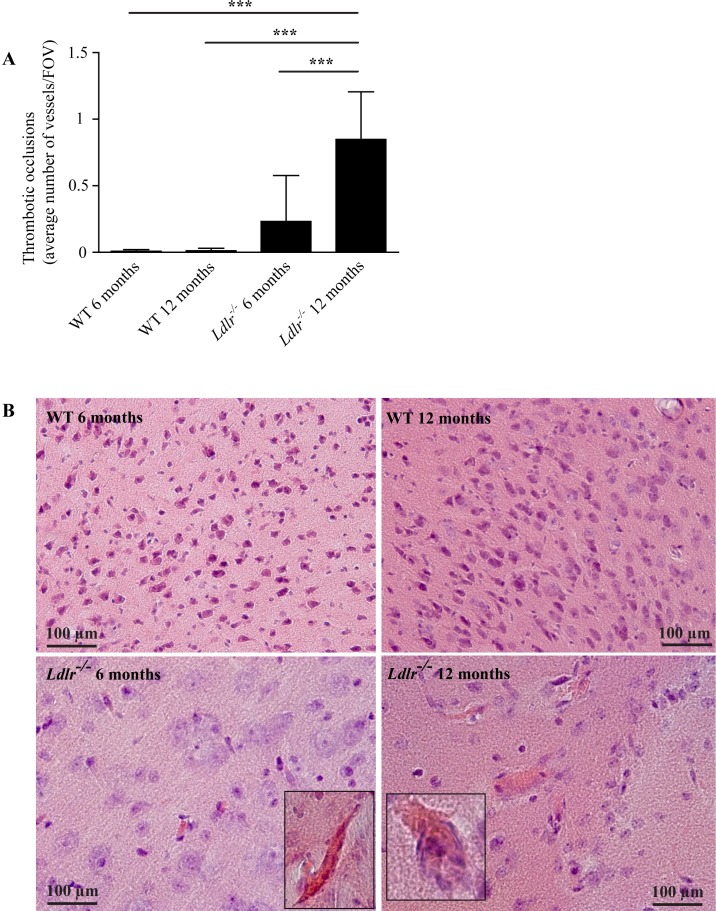
A) Thrombotic occlusions (referred to as suspected fibrin thrombi) of capillaries and arterioles of 6 and 12 months old WT and Ldlr-/- mice. 12 months old Ldlr-/- animals displayed more occlusions than any other group. Analysis of variance with Bonferroni post-hoc test, *** P < 0.001. B) Histological Hematoxylin–Eosin stainings of cortical (WT 6 and 12 months, Ldlr-/- 6 months) and hippocampal tissue (Ldlr-/- 12 months) (20x magnification). Vessel occlusions are highlighted using larger magnification (40x). WT, wild-type; FOV, field of view. Error bars indicate standard deviation.